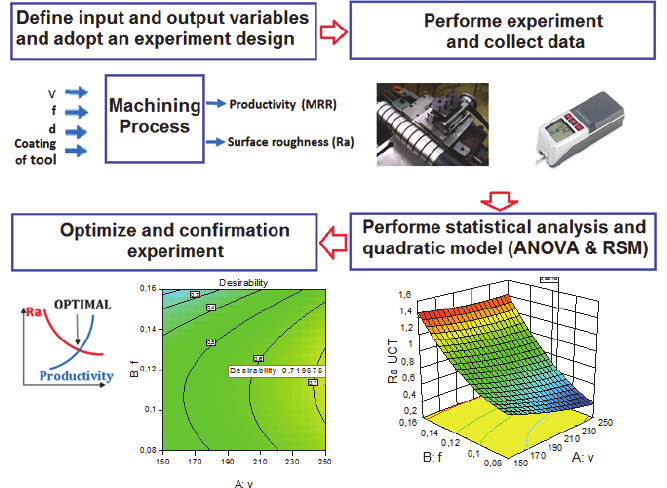
Fig.1. Experimental design flowchart Experimental results for surface roughness and material removal rate machining parameters Coated inserts Uncoated inserts Material Removal